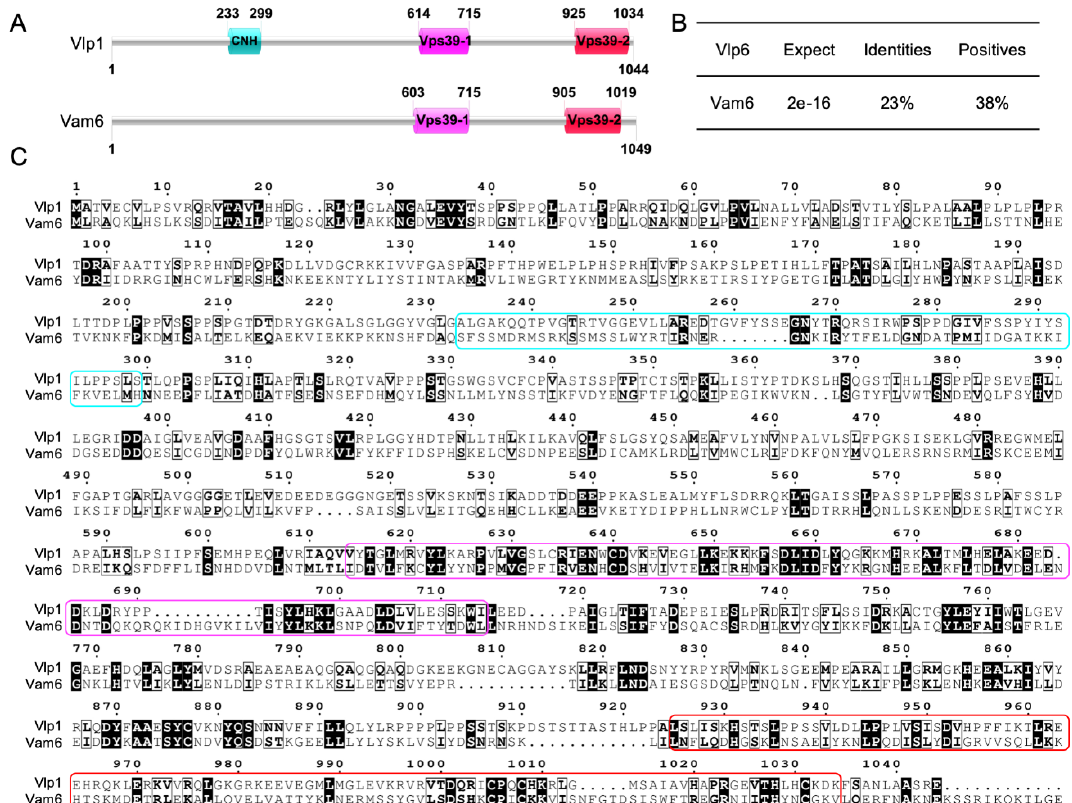
Figure 1. Sequence analysis of Vlp1 in C. neoformans . ( A ) Cryptococcal Vlp1 contains one clathrin heavy chain (CNH) domain, one vacuolar sorting protein 39 domain 1 and one vacuolar sorting protein 39 domain 2; ( B ) Cryptococcal Vlp1 shows a 23% identity and 38% similarity with the Vam6 protein in S. cerevisiae ; ( C ) Sequence alignment of Vlp1 in C. neoformans and Vam6 in S. cerevisiae . The cyan round rectangular box shows the sequence of the CNH domain; the purple and red round rectangular box shows the sequences of the Vps39-1 and Vps39-1 domains, respectively.